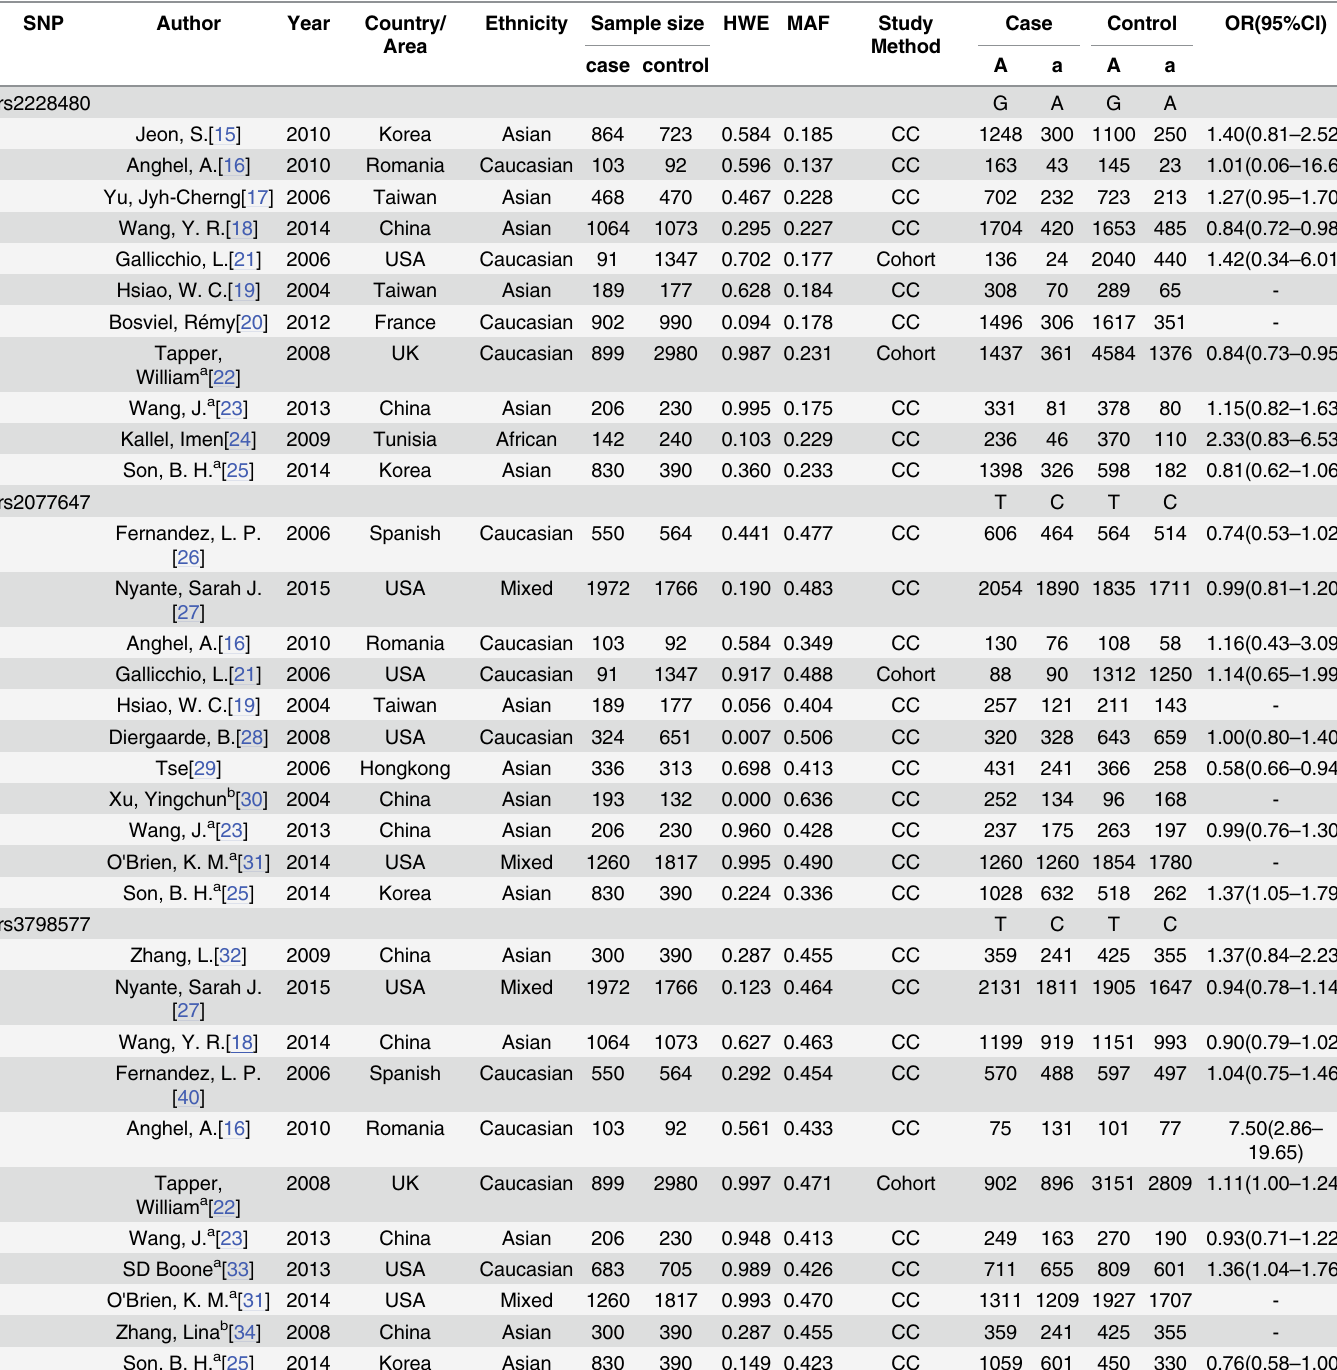
Table 1. Characteristics of all of the eligible studies of the ESR1 polymorphisms and breast